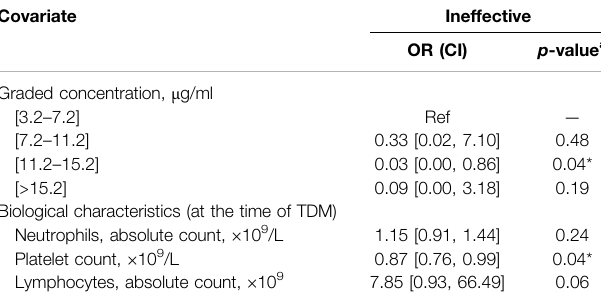
OR (CI) p -value a